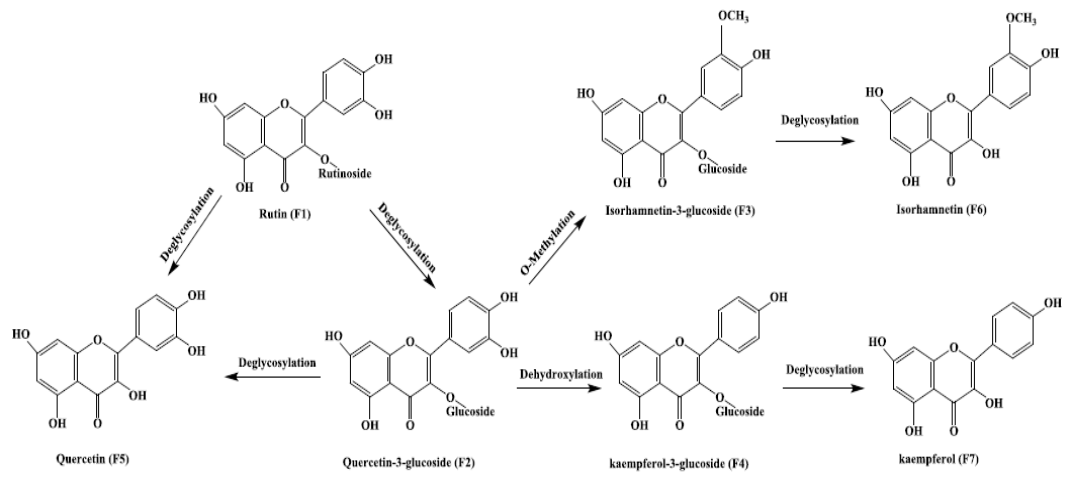
Figure 6. The proposed biotransformation pathway of rutin by E. amstelodami .